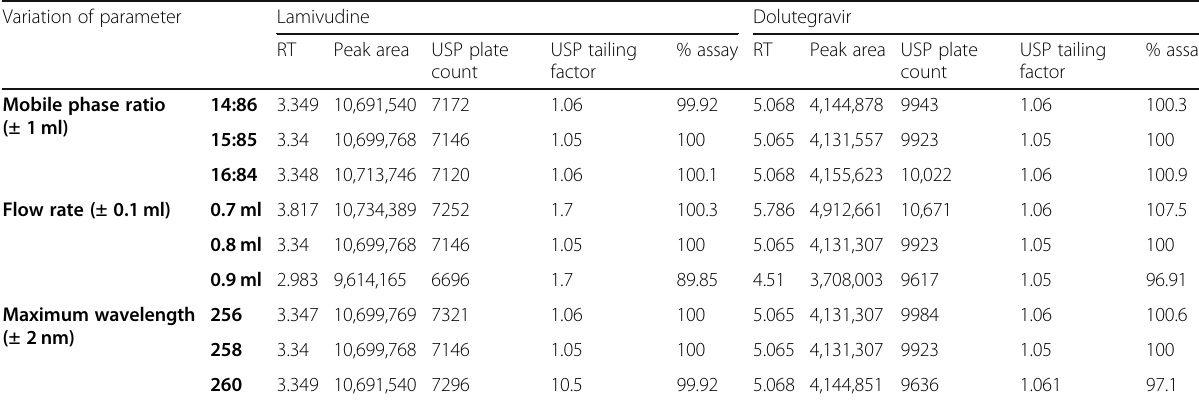
Table 6 Results of robustness of 100% level solution Variation of parameter